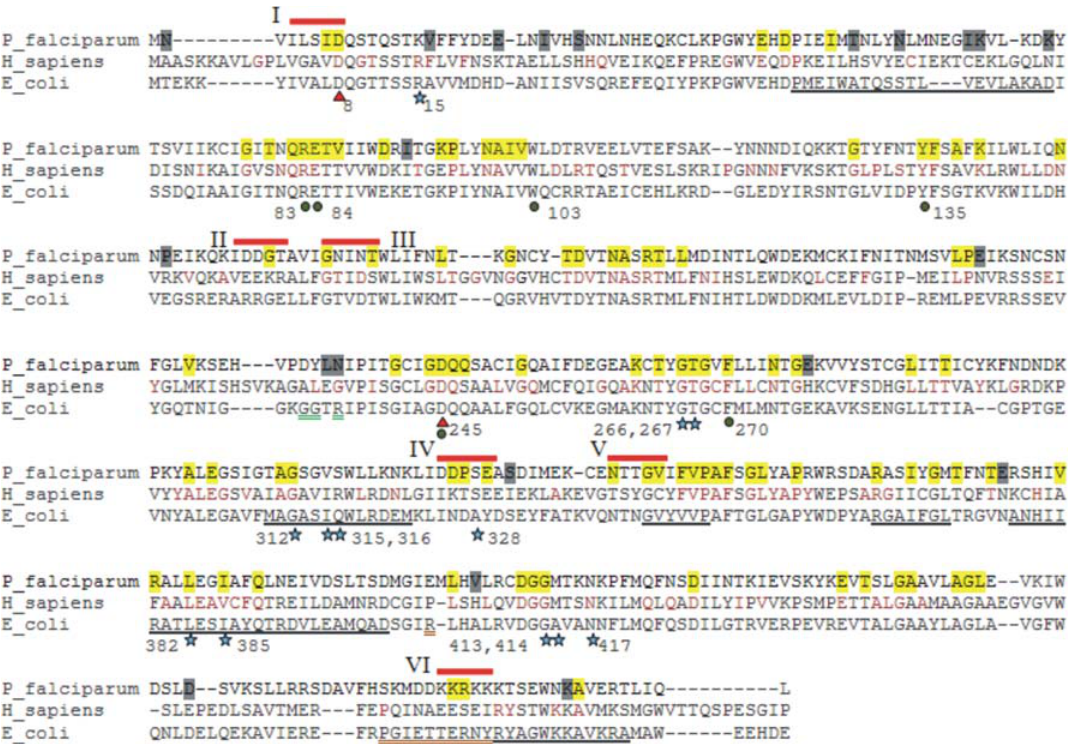
Figure 3. Multiple sequence alignment of PfGK, HsGK and EcGK. To identify differences in selective constraints, PfGK and HsGK were analyzed separately, as part of protozoan and metazoan clades, respectively, and compared. Residues under extreme purifying selection are highlighted in yellow in PfGK and are in brown font in HsGK. Residues highlighted in gray in PfGK are under neutral or positive selection. Sites that bind glycerol (green circle), ADP (blue star) and magnesium (red triangle) were determined from the crystal structure of EcGK [24]. Corresponding residues in PfGK were determined form the MSA. Residues are numbered according to the PfGK sequence. Potential drug target sites are indicated (red bar) and labeled with Roman numerals. Underlined regions in EcGK are implicated as follows: intersubunit interactions (black), FBP regulatory site (green) and IIA Glc regulatory site (orange).